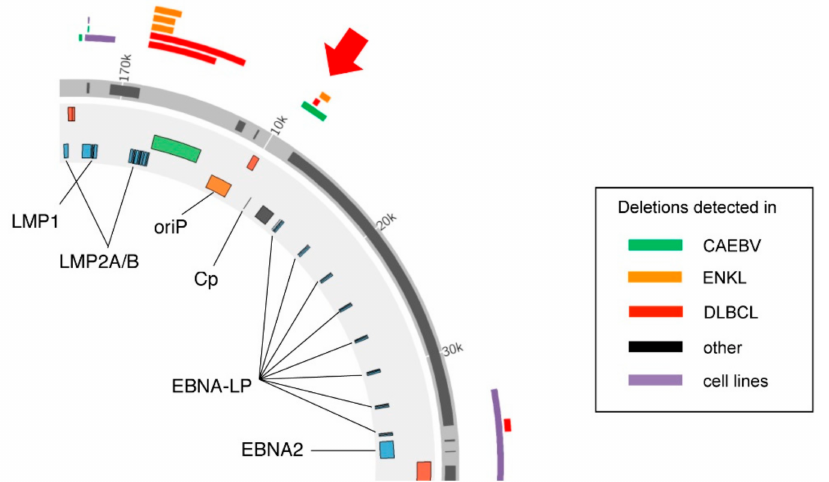
Figure 1. Deletion of the Epstein–Barr virus (EBV) genome in EBV-positive cancer specimens. Map of the deletions in C promoter (Cp) found in our previous study (Okuno et al. Nature Microbiology, 2019). These deletions were present in chronic active EBV infection (CAEBV), EBV-positive diffuse large B-cell lymphoma (DLBCL) and extranodal natural killer (NK)/T-cell lymphoma, nasal type (ENKL) patients. Modified from (Murata et al. Reviews in Medical Virology,